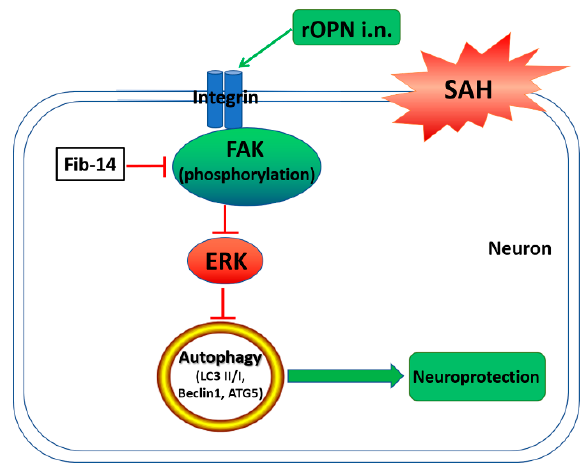
Figure 9. Graphical abstract. SAH, subarachnoid hemorrhage; rOPN, recombinant osteopontin; i.n., intranasal administration; Fib-14, FAK inhibitor 14.